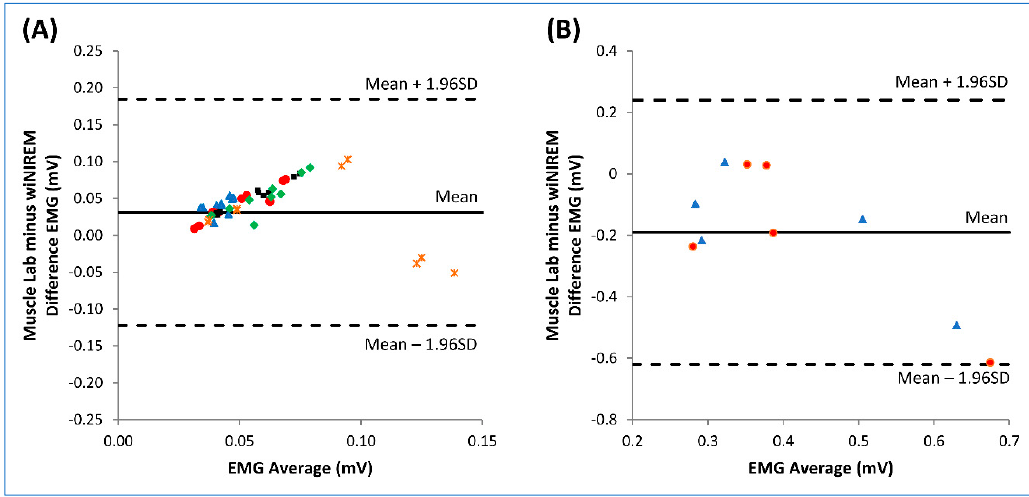
Figure 7. Bland–Altman plots of the difference of vastus lateralis (VL) surface electromyographic activity (sEMG, Root Mean Square-RMS) obtained by wiNIREM and Muscle Lab during run ( A ) and dynamic high squat ( B ). ( A ) Each point was obtained with the RMS values of the last 20 s of submaximal treadmill run performed at each speed (blue triangle = 4 km/h, red circle = 10 km/h, black square = 12 km/h, green rhombus = 14 km/h and orange asterisk = 16 km/h). ( B ) Each point was obtained with the RMS values corresponding to the first (blue triangle) and last repetition (red circle) of the dynamic high squat performed at 50% of maximal isometric voluntary contraction. The comparisons were performed on the dominant leg. The upper and lower dotted horizontal lines correspond to ±1.96SD and the center line represents the bias.